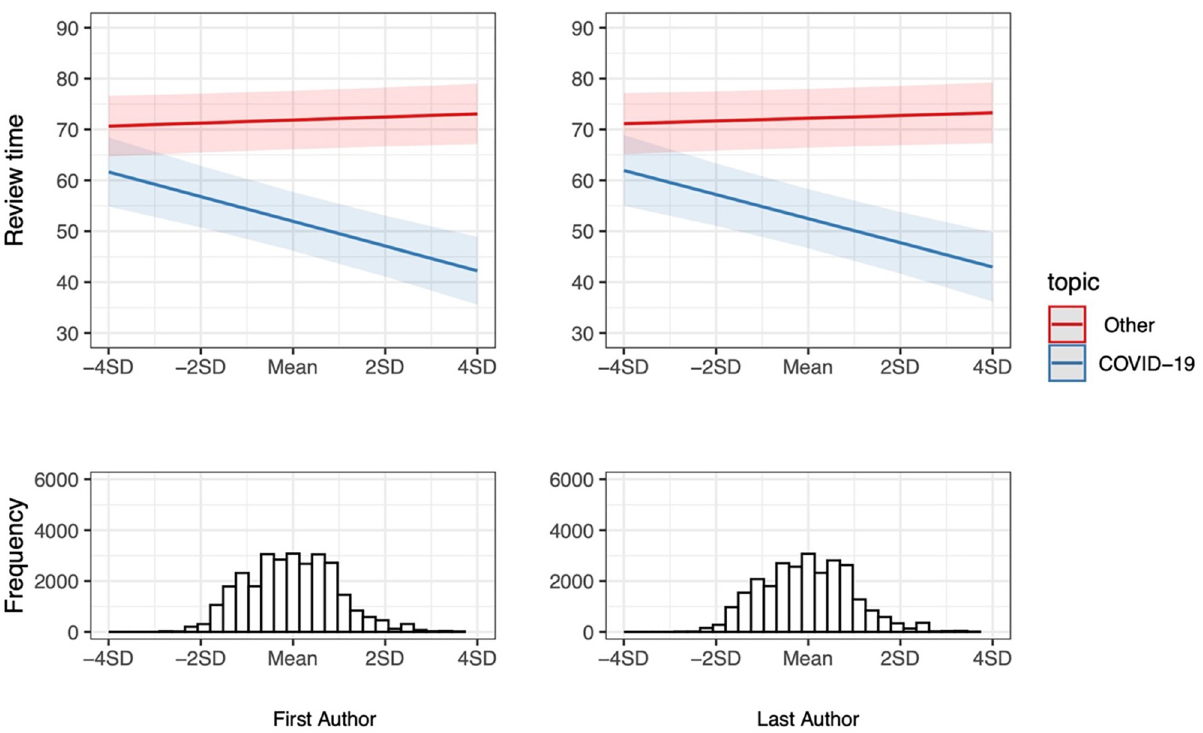
Fig 1. Estimated difference in average review time of COVID-19 papers (red line) and other medical research (blue line) published in 2020 by authors from lower and higher ranked institutions. The Y-axis reports the number of days from manuscript submission to acceptance. The X-axis scores Institution status (according to the Leiden Ranking’s PP-top 10% measure) by standard deviations. The light red and light blue areas around the lines indicate the 99% confidence intervals. The histograms below the interaction plots display the frequency distribution of papers across various levels of Institution status.